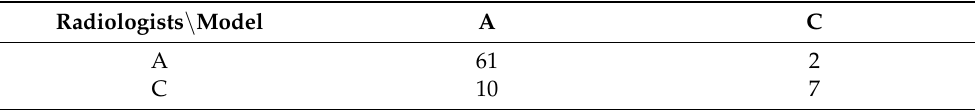
Table 2. Confusion matrix illustrating the developed model’s stage detection. The cases dominated with GGO and crazy paved pattern area are classified as “A” group, and “C” represents the cases with significant consolidation area (blobs). Radiologists \